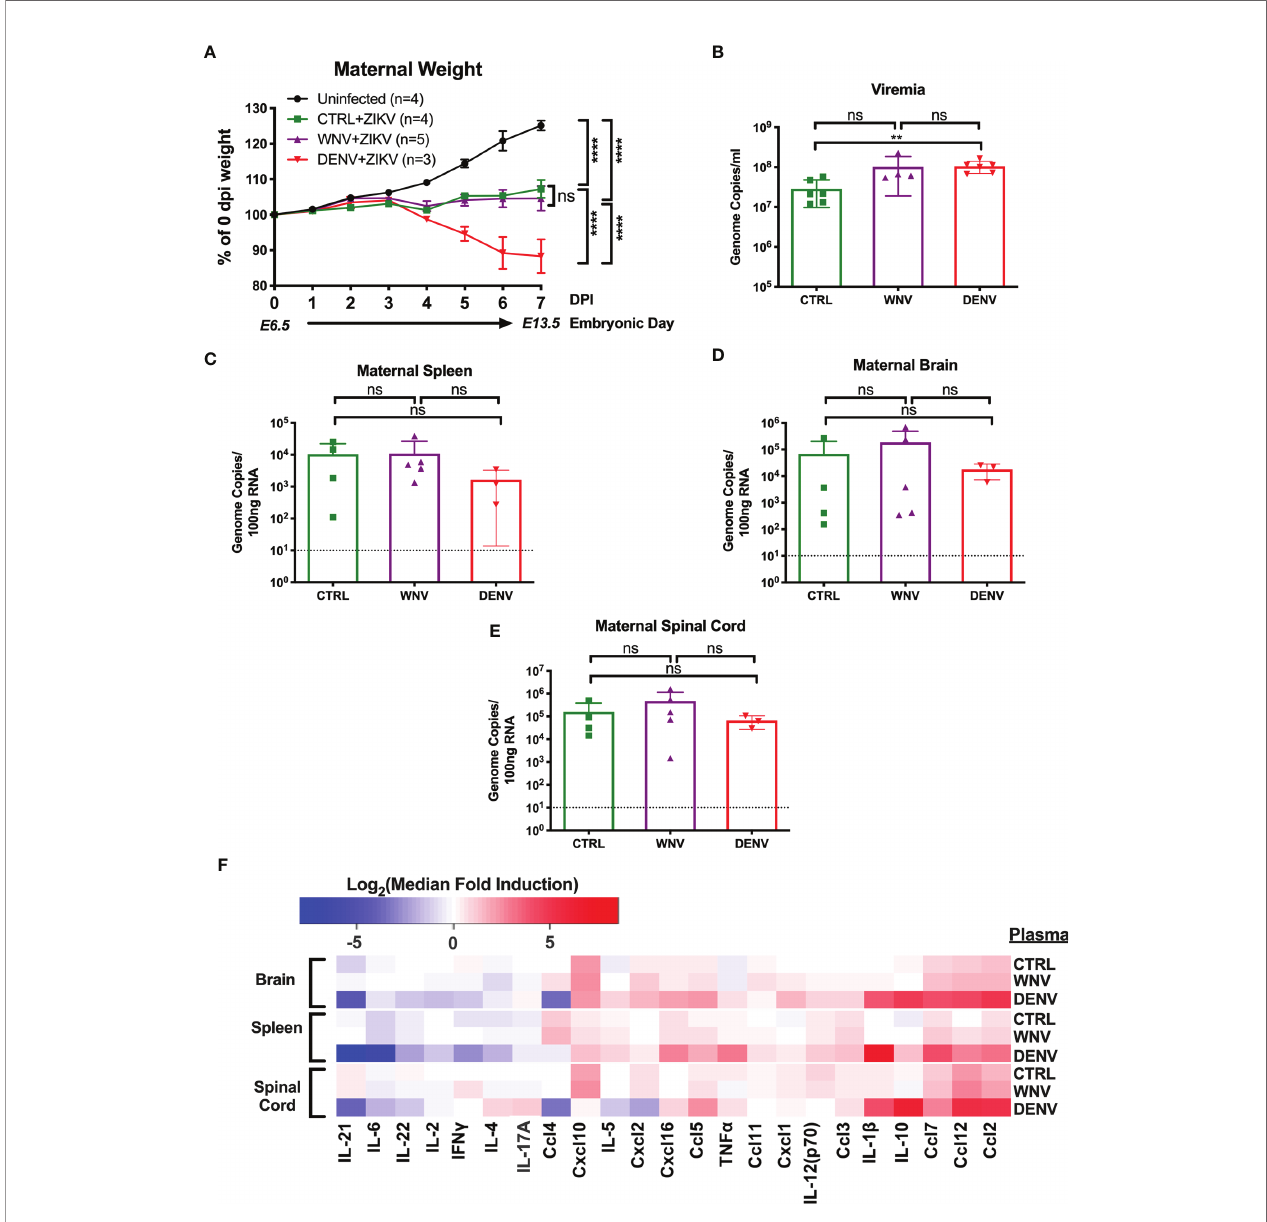
FIGURE 2 | Impact of WNV antibodies on ZIKV infected dams. ZIKV-infected Stat2 -/- dams that received 20 m l of either CTRL (n=4), WNV (n=5) or DENV (n=3) plasma were compared to uninfected dams that also received WNV or CTRL plasma (n=4; See Figure S1 ). (A) Maternal weights between infection at E6.5 and tissue collection at E13.5 are shown as a percentage of starting weight at E6.5. Signi fi cance was determined by two-way ANOVA, and error bars represents SD. (B) Viremia was determined at 3 days post infection in ZIKV-infected dams by qRT-PCR. Mice included in this sub fi gure are from an unmatched cohort of CTRL (n=6), WNV (n=4), and DENV (n=6) mice. Viral loads in dams from (A) were determined in the maternal spleens (C) , brains (D) , and spinal cords (E) by qRT-PCR. For (C – E) , dotted lines indicate the limit of detection, and mean values with SD are depicted with the overlaid bar plots. Signi fi cance was determined by Mann-Whitney U-test. (F) Tissue homogenates from brain, spleen and spinal cords from ZIKV-infected mice in (A) were evaluated for in fl ammatory markers by multiplex ELISA. Data are shown as a log 2 transformed median fold induction over the median pg/ml expression in the uninfected condition. ns, not signi fi cant; ** p < 0.01, **** p <